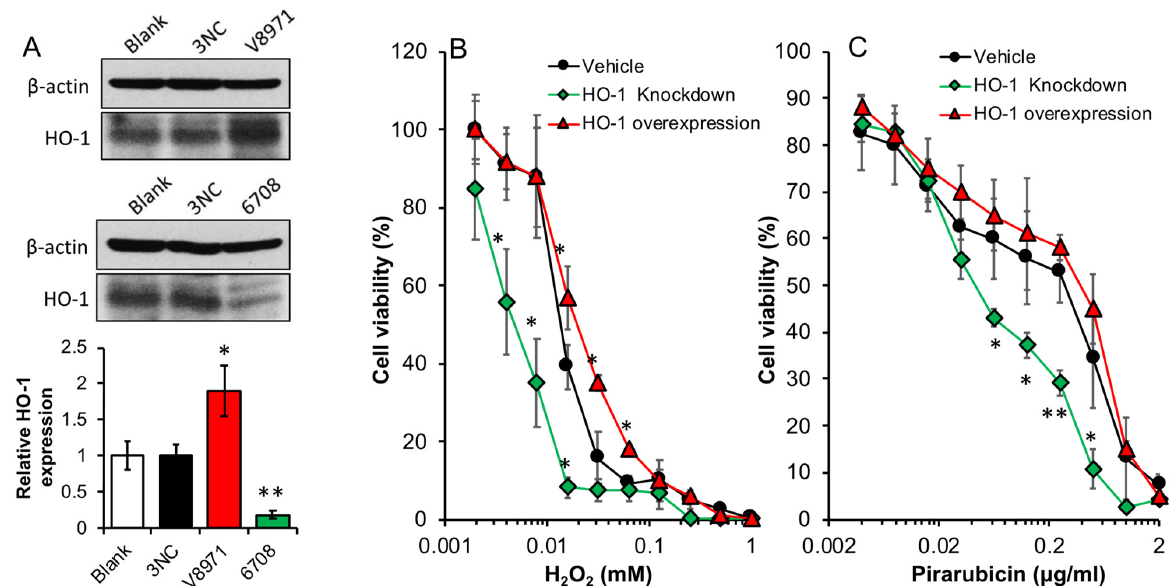
Figure 4. Cytotoxicity of hydrogen peroxide and anticancer drug pirarubicin against colon cancer C26 cells with different expression levels of HO-1. Colon cancer C26 cells transfected with HO-1 (V8971) or HO-1 shRNA (6708) to over-express or knock down HO-1 in the cells, which showed significantly increased or decreased HO-1 expression, compared to C26 cells transfected with empty vector (3NC) ( A ). To each cell line, hydrogen peroxide ( B ) or anticancer drug pirarubicin ( C ) was added and the cells were treated for 48 h, followed by the MTT assay. Data are mean ± SEM, n = 3 for ( A ), and n = 6–8 for ( B , C ). * p < 0.05; ** p < 0.01 vs. vehicle or blank. See text for details.